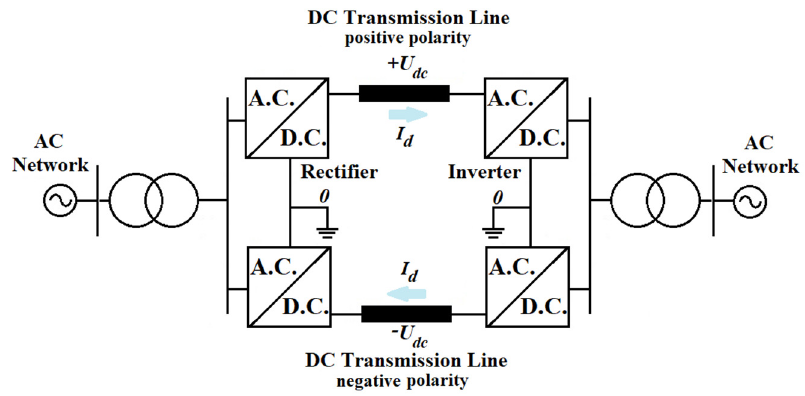
Figure 4. HVDC bipolar links ground return.